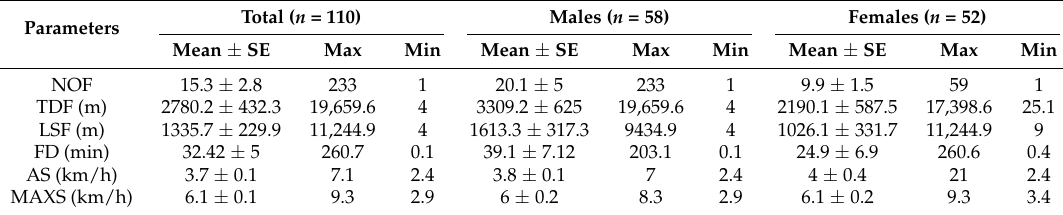
Table 5. Summary of flight parameters for R. ferrugineus adults.